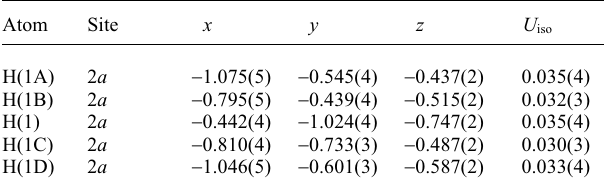
Table 2. Atomic coordinates and displacement parameters (in Å 2 )